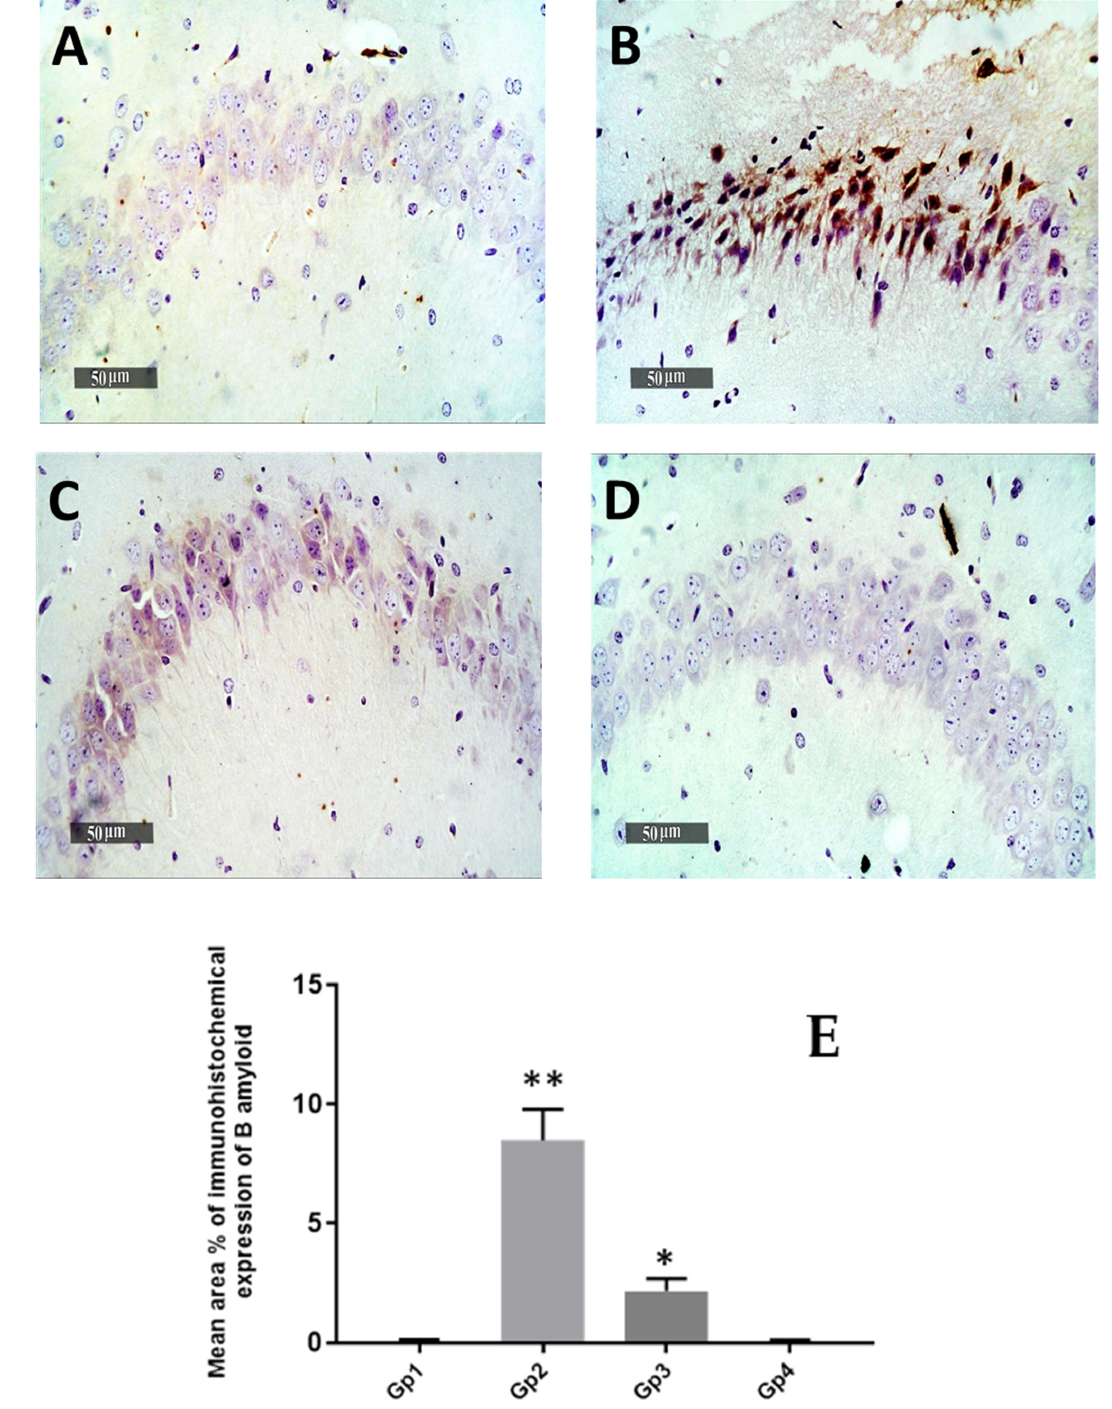
Figure 10. Effect of different treatments on hippocampal IbA/++ activated microglial cells count expressed as the mean number of IbA/++ cells per microscopic field. ( A ) Normal group, ( B ) Negative control group, ( C ) Positive control group and ( D ) Test group. 400×. The bar chart ( E ) shows the mean ± SD of the % area of immuno-histochemical levels expression of GFAP, where Gp 1 represents the normal group, Gp 2, Gp 3 and Gp 4 represent the negative control group (received 0.9% saline), positive control group (received resveratrol suspension) and test group (received resveratrol bilosomes), respectively, where (*), (**) and (***) indicate statistically significantly different values from the control group at ( p < 0.05, p < 0.01 and p < 0.001), respectively .